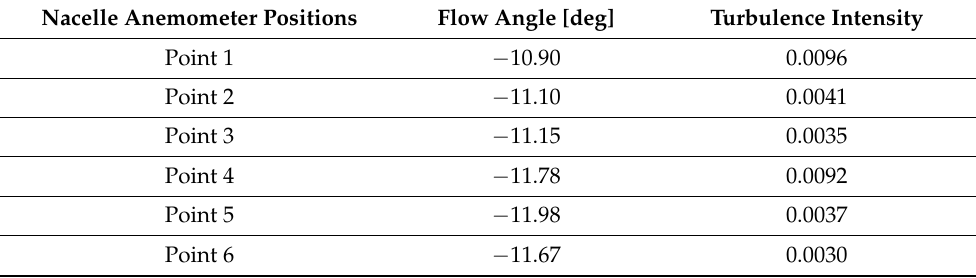
Table 4. Effect of anemometer positions on FA and T i .